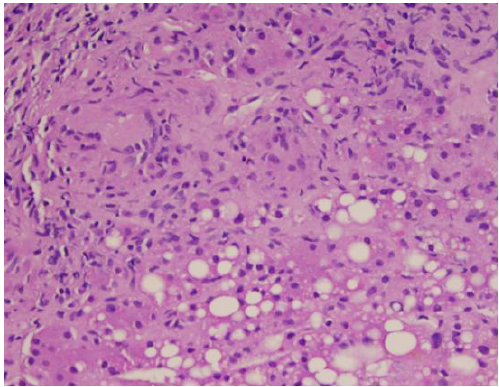
FIGURE 2 . H&E section of the liver biopsy demonstrating granulomas (arrow) with elongated histiocytes and multinucleated giant cells.